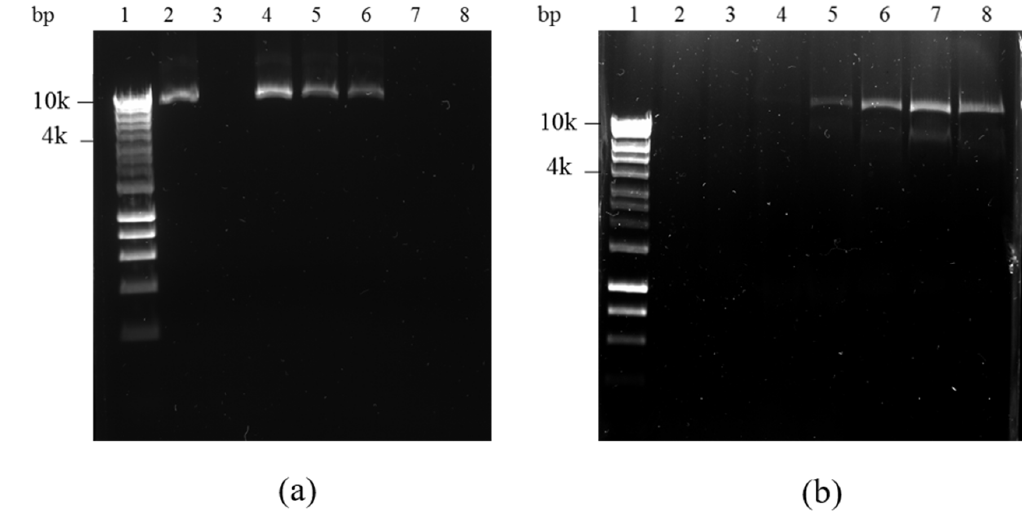
Figure 3. Agarose gel electrophoresis of a range of DNA:SLN-A weight ratios. ( a ) DNA binding assay: Lane 1—Hyperladder I, lane 2—plasmid DNA only, lane 3: SLN-A only, lane 4–8: 1:1, 1:5, 1:10,